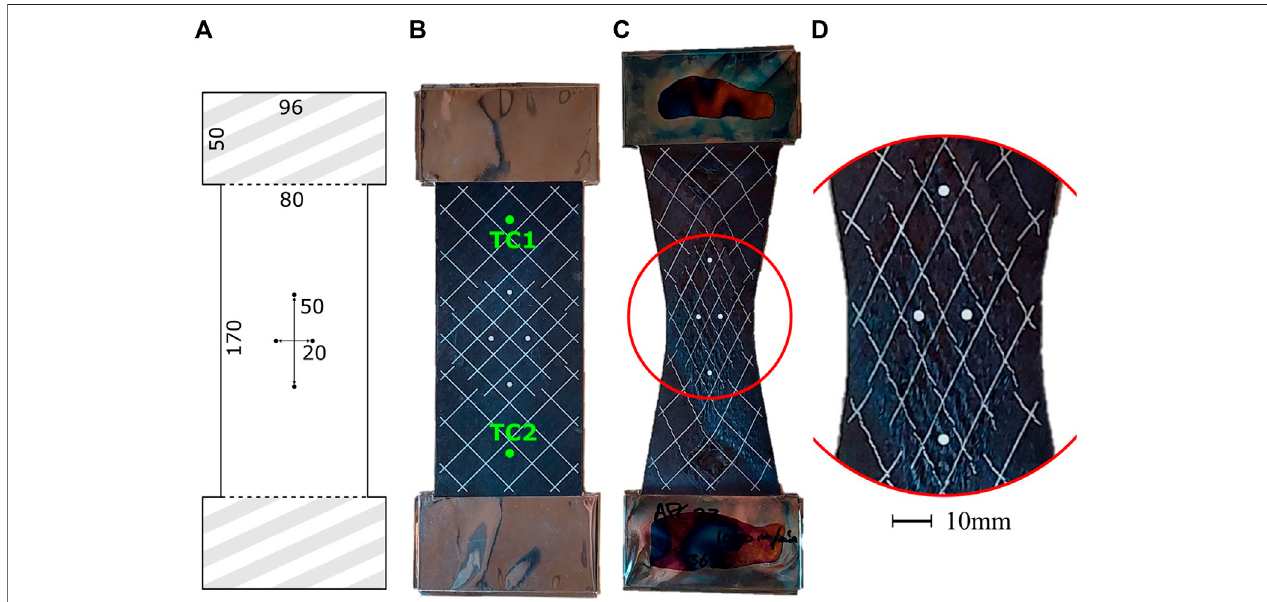
FIGURE 2 | From left to right. (A) Specimen dimensions in millimeters. Shaded area will be clamped. (B) Specimen prepared for bias extension testing, location of two thermocouples indicated (TC1 and TC2). (C) Deformed specimen after bias extension testing. (D) Zoom of the central area with localization visible from the jagged lines.